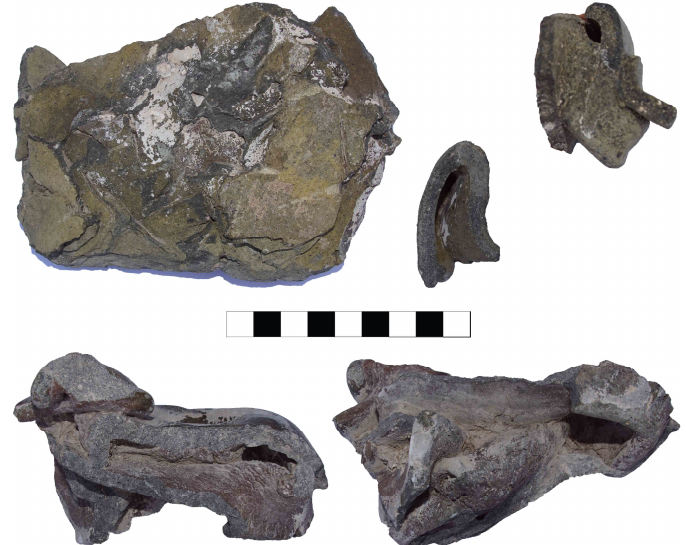
Figure 25. Kiln furniture and wasters from the Late Antique (Late Roman) pottery workshop in the Xeros River valley (Image by Athanasios K.